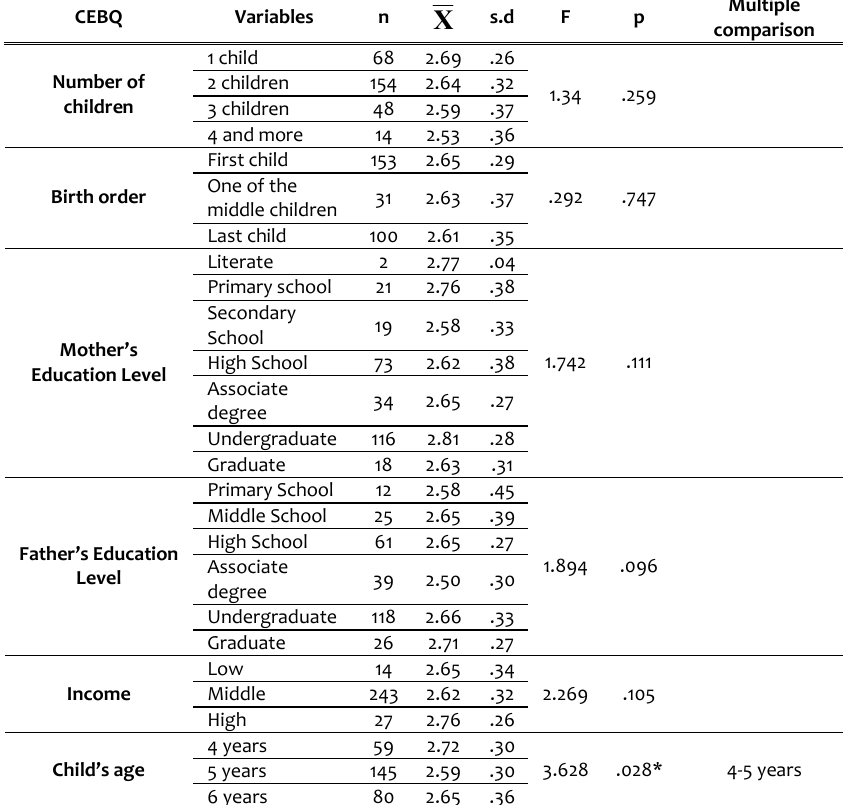
Table 3. Results of ANOVA Test Related to CEBQ Total Scores and number of Children, Birth Order, Parental Education Level, İncome, and Child’s age